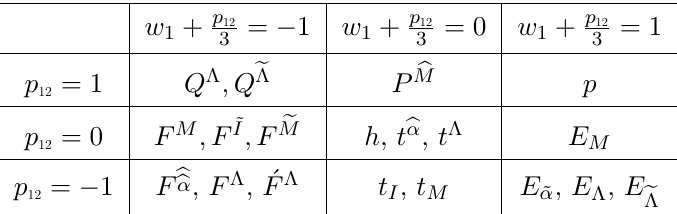
( e ) and w the p 12 12 1 = − 3 and 12 2